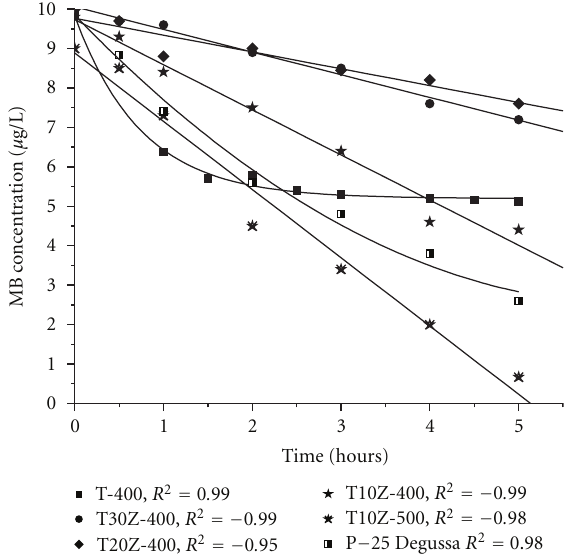
Figure 9: Kinetic plots of MB concentration versus reaction time.